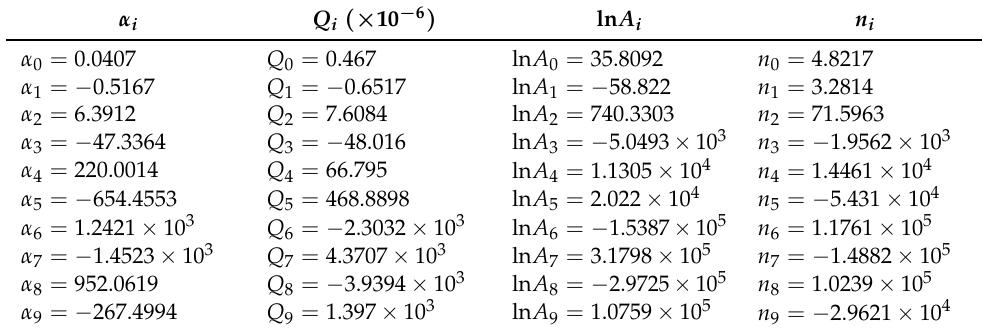
Table 5. Parameter values of the Arrhenius flow law for the medium carbon